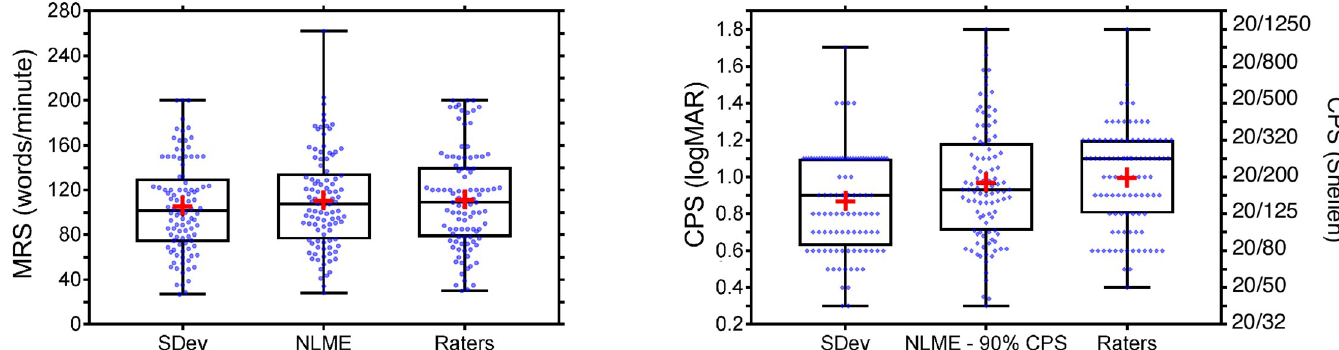
Fig 5. Box and whisker plots showing MRS (left panel) and CPS (right panel) obtained with the two algorithms and the mean for all raters. The box represents 25th to 75th percentile with median line, the red + sign represents the mean and the whiskers represent minimum to maximum.